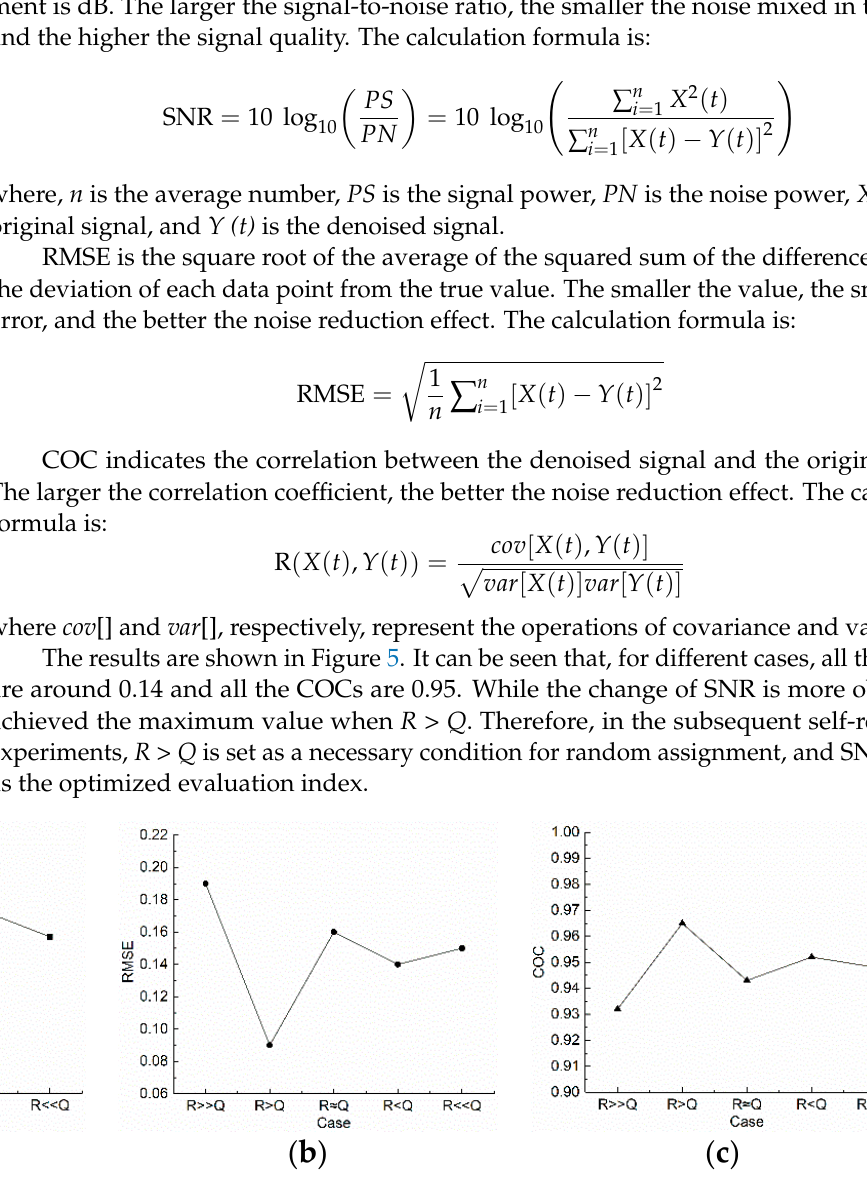
Figure 5. Using ( a ) SNR, ( b ) RMSE, and ( c ) COC to compare the filtering effect in different magnitude relationships between Q and R .